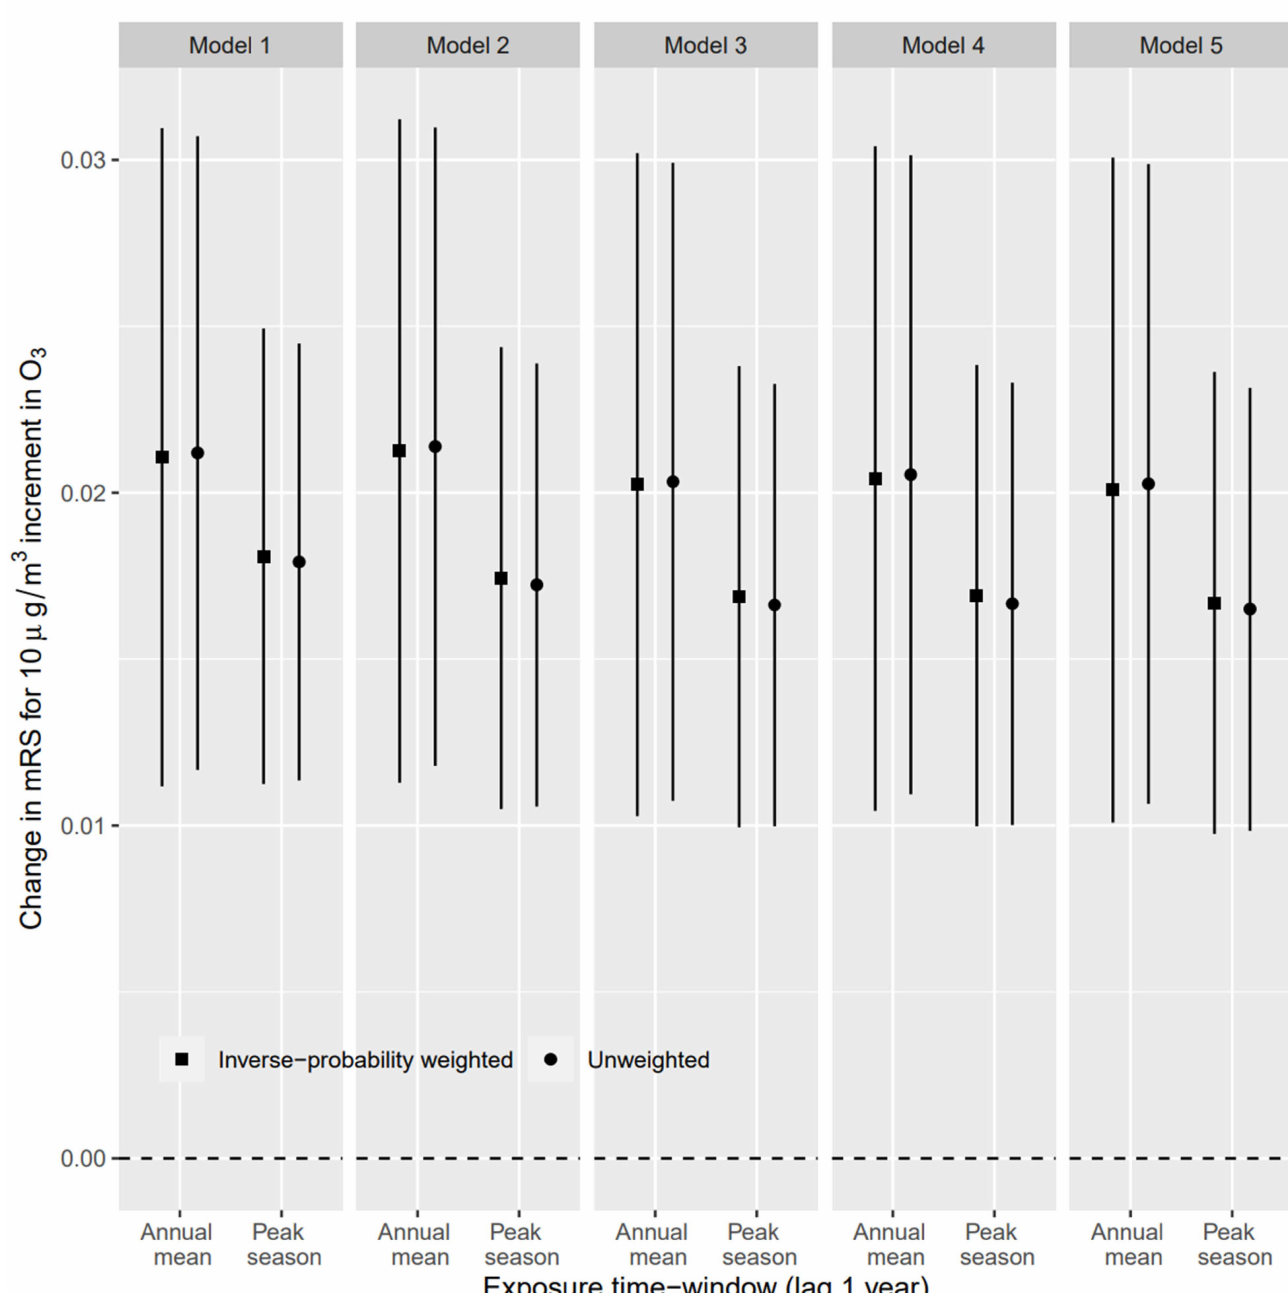
Figure 1. Associations of O 3 exposure with mRS score based on different model settings. Model 1 was only adjusted for the interaction of the follow-up period with age at baseline and the interaction of the follow-up period with years after stroke at baseline. Model 2 was additionally adjusted for season. Model 3 was additionally adjusted for smoking, drinking, physical activity, milk intake, and body mass index. Model 4 was additionally adjusted for PM 2.5 . Model 5 was additionally adjusted for hypertension, diabetes, dyslipidemia, and atrial fibrillation. mRS, modified Rankin